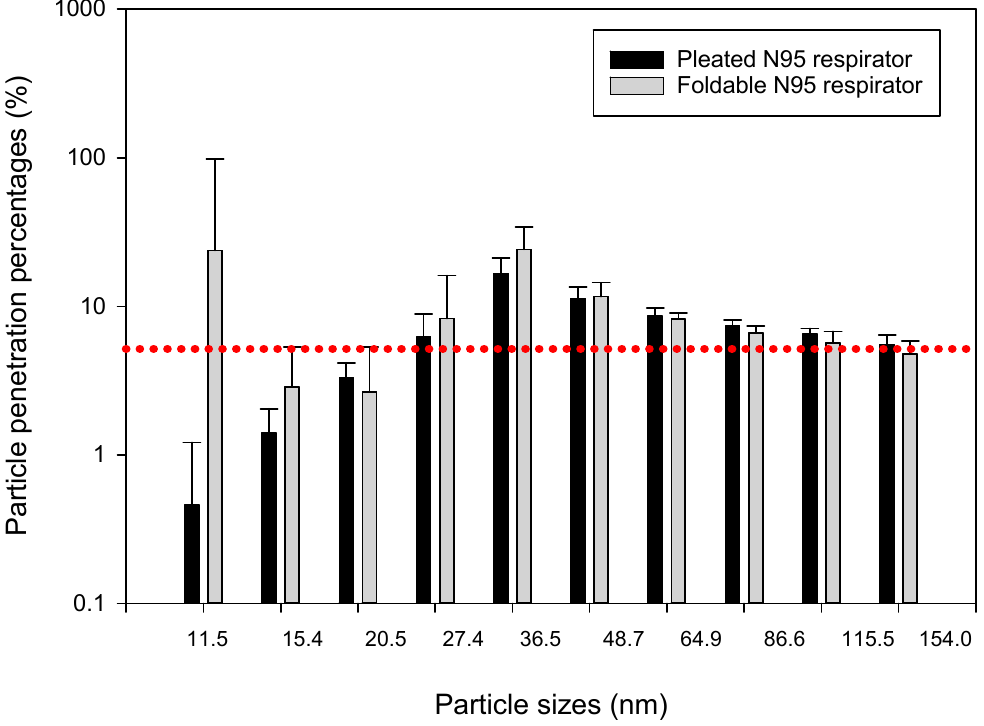
Figure 4. Penetration percentages of particles of 11.4–154.0 nm size range during concrete blasting and grinding. The dotted red line indicates the 5% particle penetration percentages, to be considered as the efficacy threshold for N95 respirators.